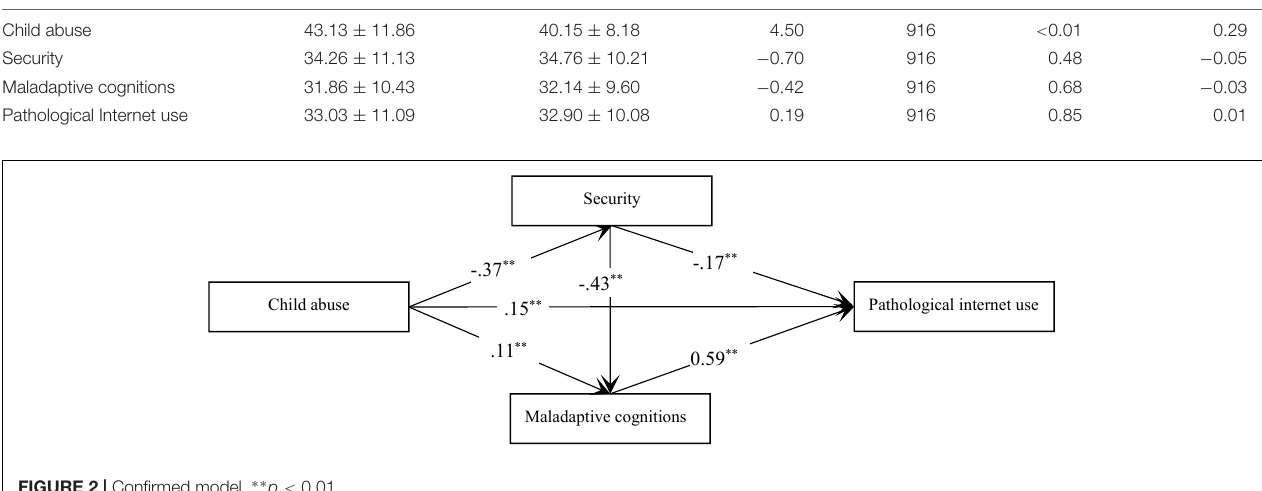
FIGURE 2 | Confirmed model. ∗∗ p <